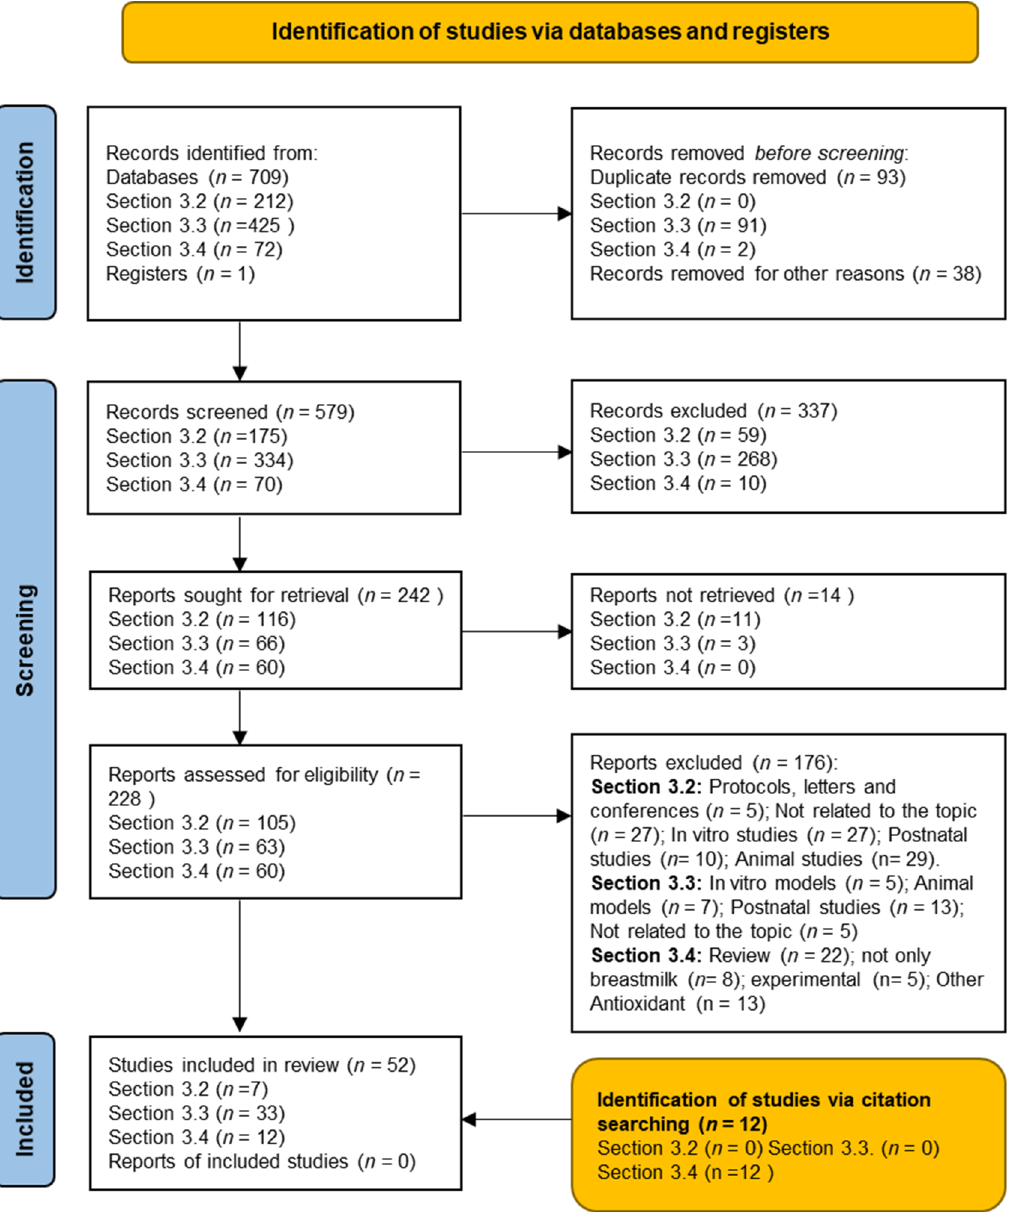
Figure 1. Methodological flowchart based on the PRISMA 2020 update following preferred reporting items for systematic review [20].